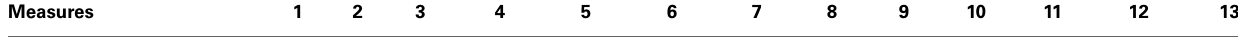
Table 1 | Intercorrelations and descriptive statistics for number-specific, domain-general ability and math competency measures.